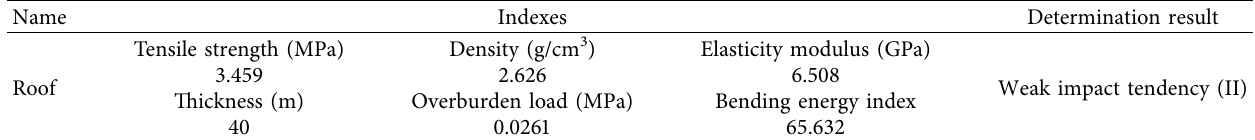
Table 4: Testing result of roof samples impact tendency.